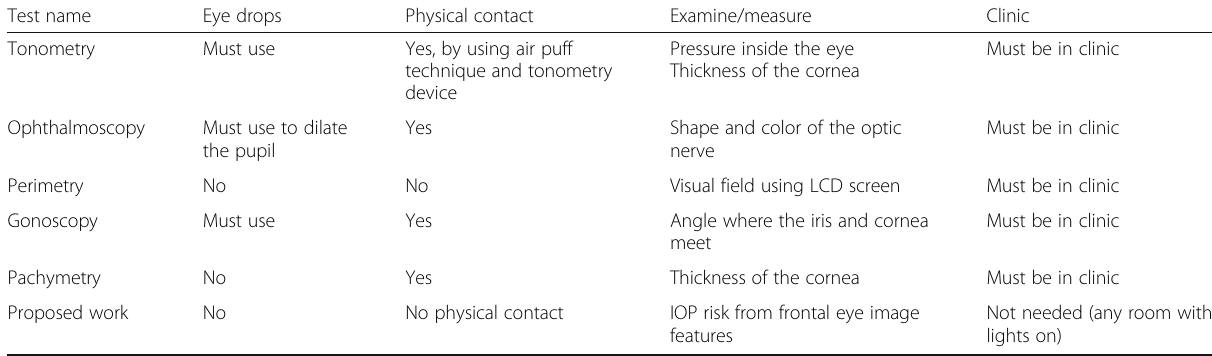
Table 1 Comparison with existing clinical